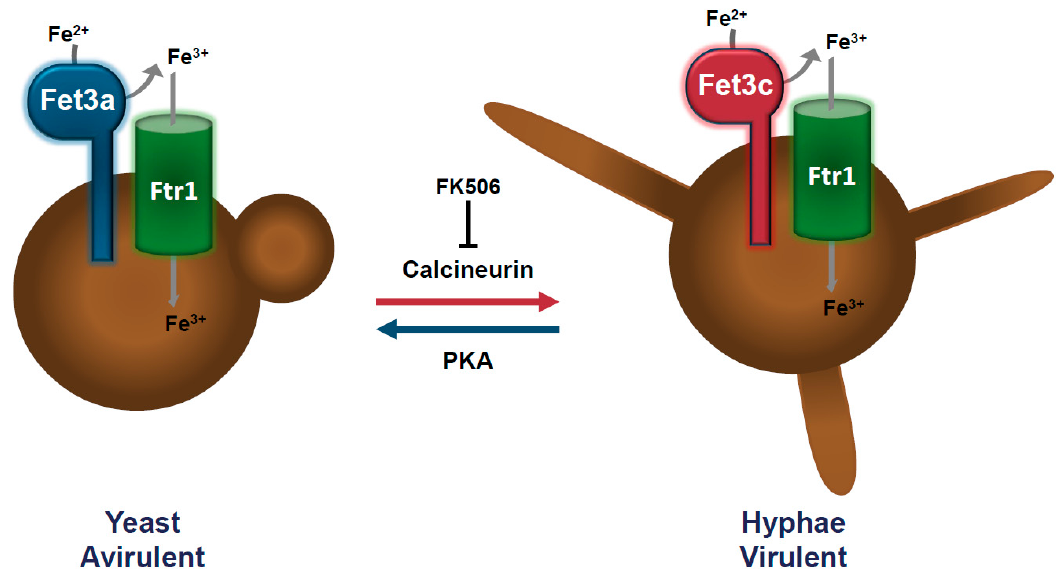
Figure 1. The interplay of calcineurin, protein kinase A (PKA), and iron uptake systems in dimorphism and virulence of Mucor circinelloides.